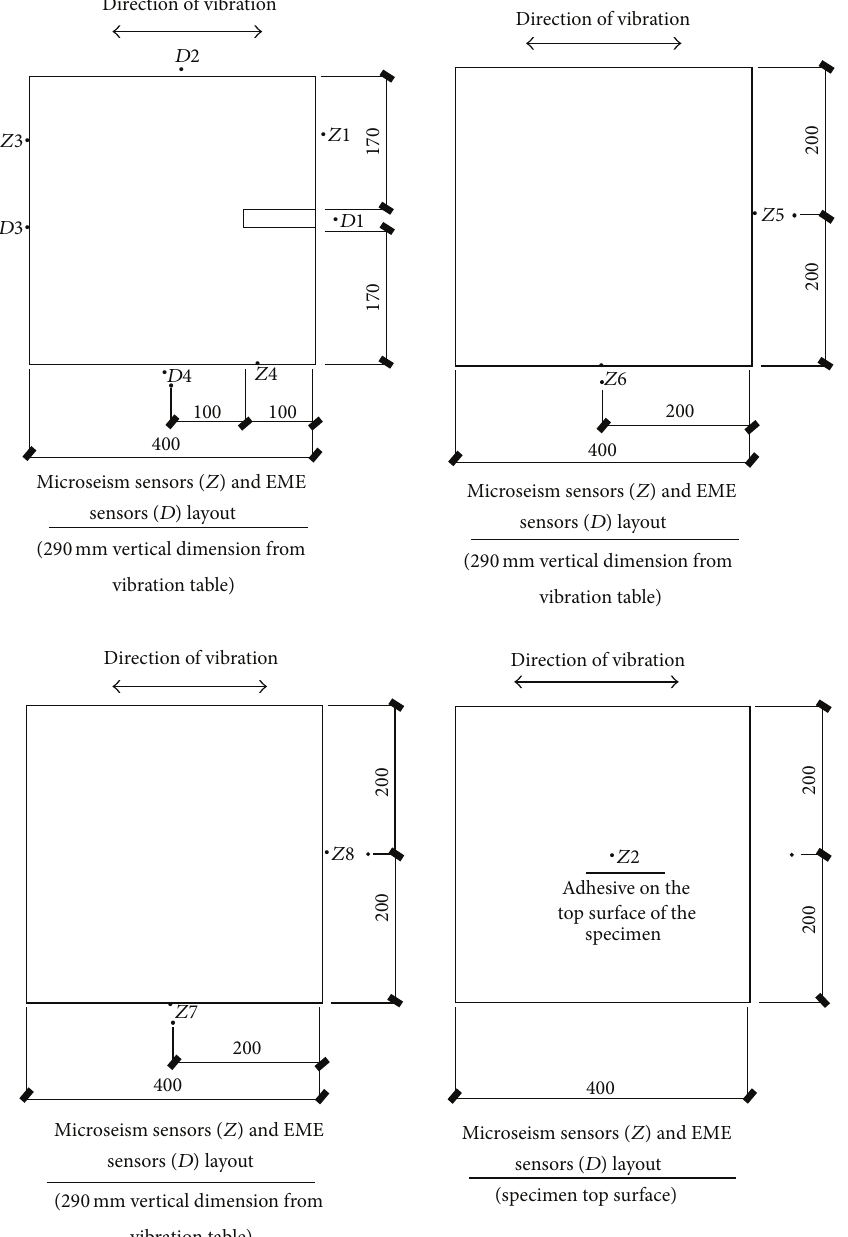
Figure 10: Microseism sensor and EME sensors (electromagnetic emission sensors are used for measuring EME signals which are not discussed in this paper)